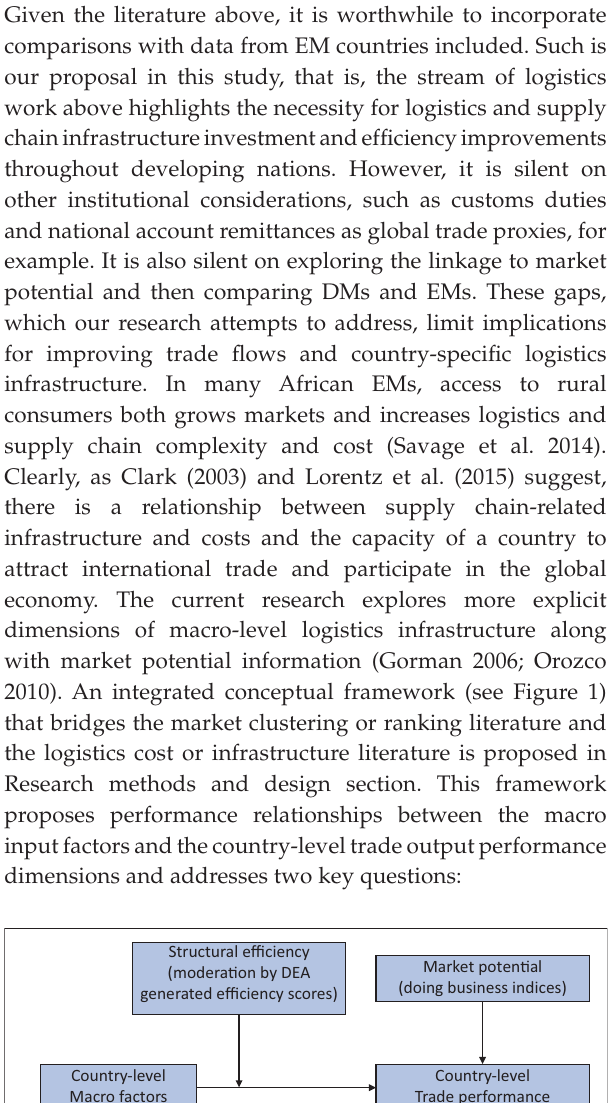
Country-level Macro